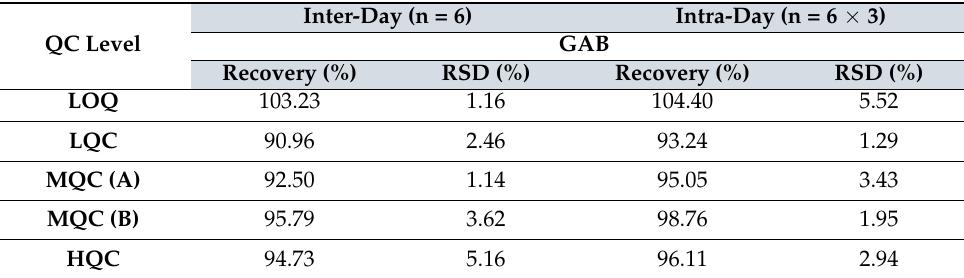
Table 3. Precision and accuracy outcomes for the analysis of GAB in human plasma samples.